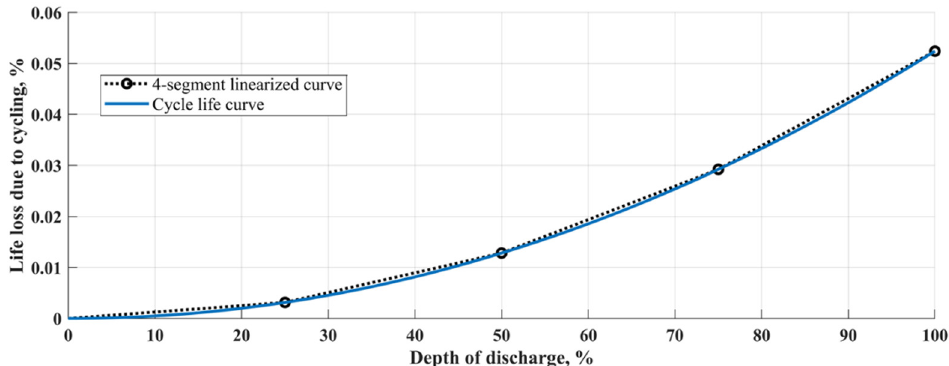
Figure 7. Linearization of BESS degradation (for illustrative purposes).